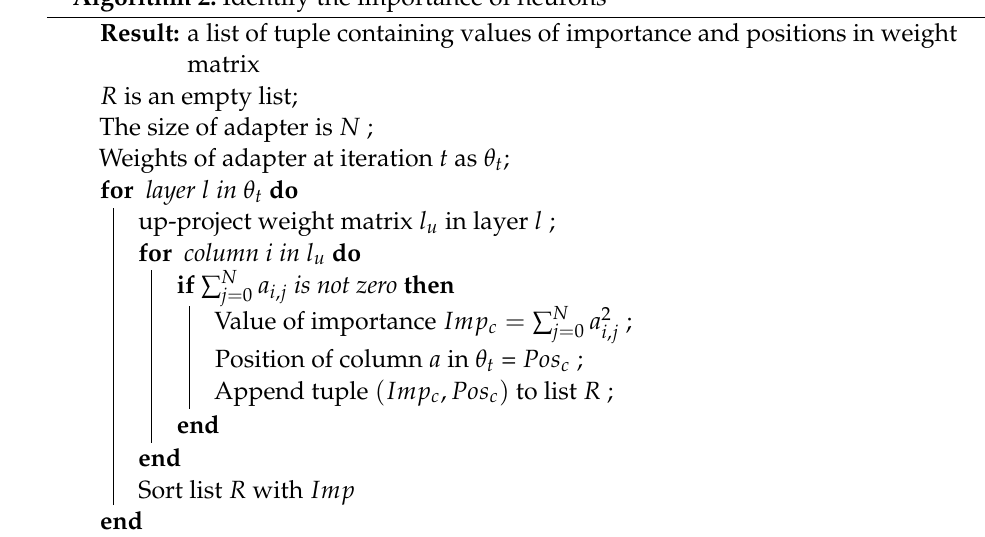
Algorithm 2: Identify the importance of neurons